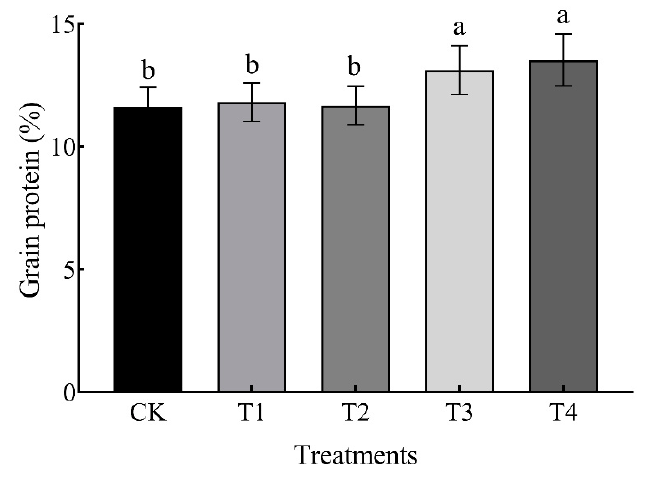
Figure 7. Winter wheat grain protein content (%) under different irrigation regimes; vertical bars represent standard errors (SE, n = 3). Different lowercase letters show that the mean values are significant based on LSD multiple range tests at p < 0.05.